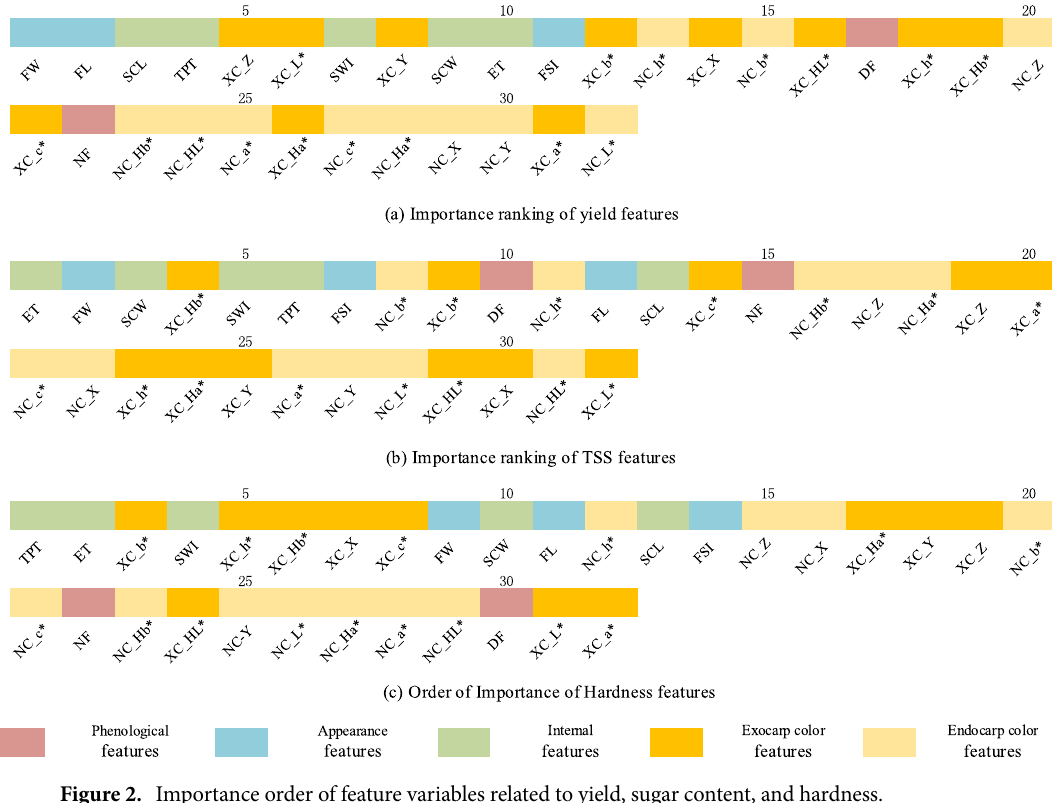
Figure 2. Importance order of feature variables related to yield, sugar content, and